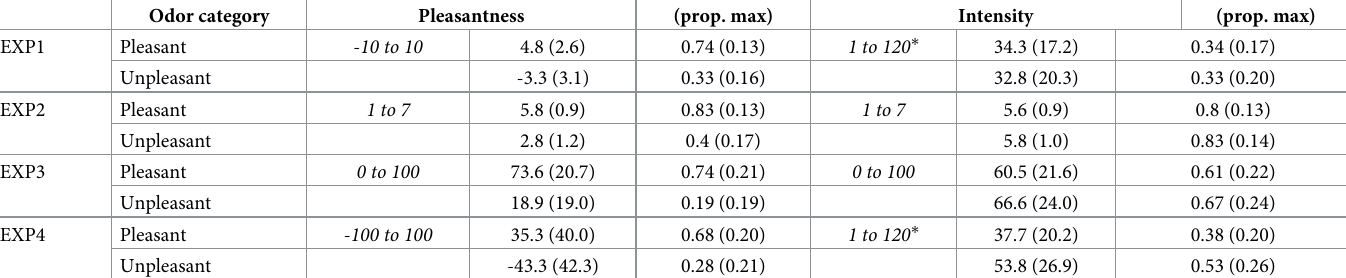
Table 3. Mean (standard deviation) odor ratings of pleasantness and intensity in each experiment (EXP), separately for two odor categories (pleasant and unpleas- ant). Text in italics indicates the range of the scales used. To ease the interpretation of the ratings done on different scales, we transformed the raw scores into proportions of the maximal value on each scale (prop. max). * Borg CR-100 scale [32]. In this scale, the maximal value is 100, but participants can go beyond the maximal value (up to 120).